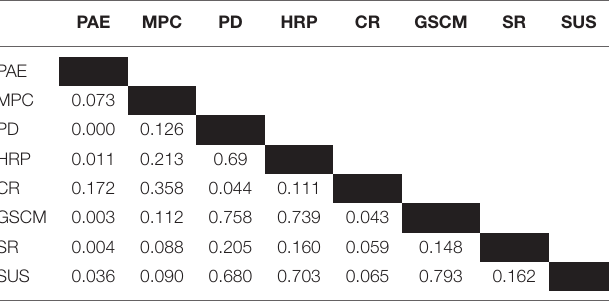
TABLE 3 | Discriminant